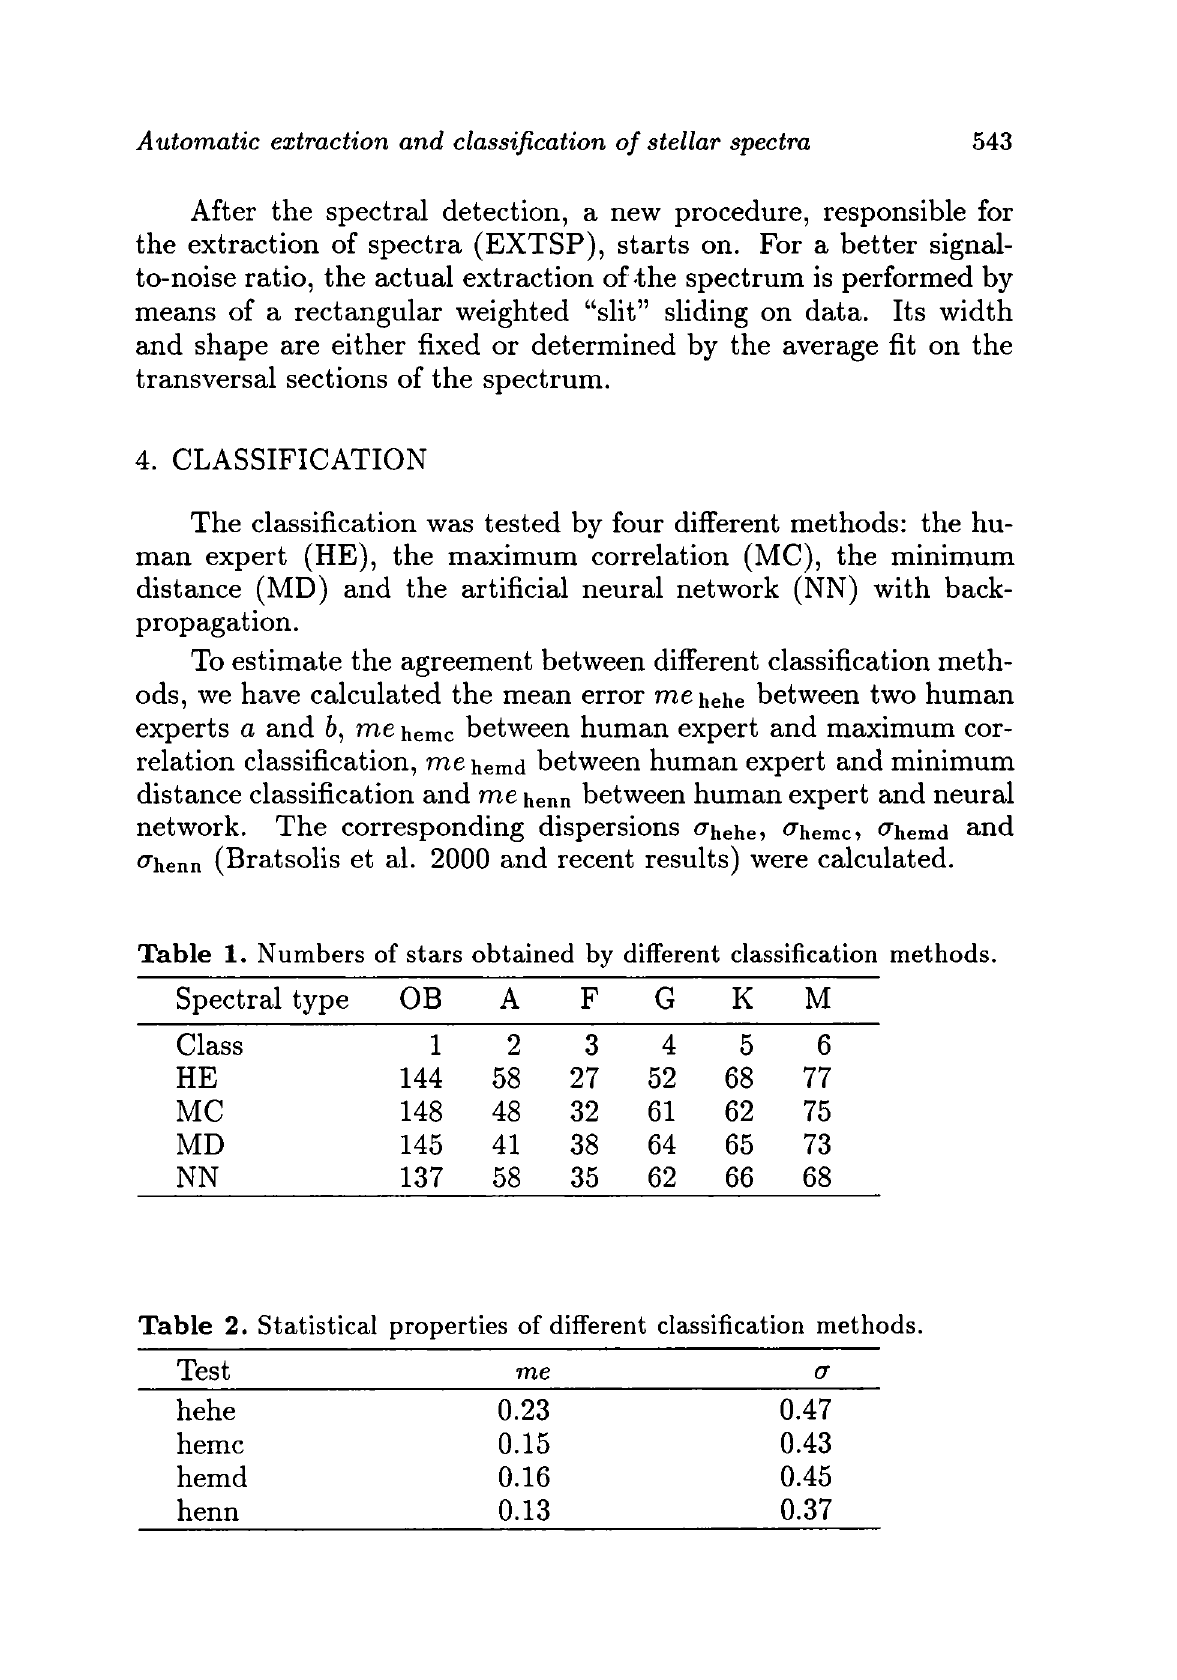
Table 1. Numbers of stars obtained by different classification methods. Spectral type